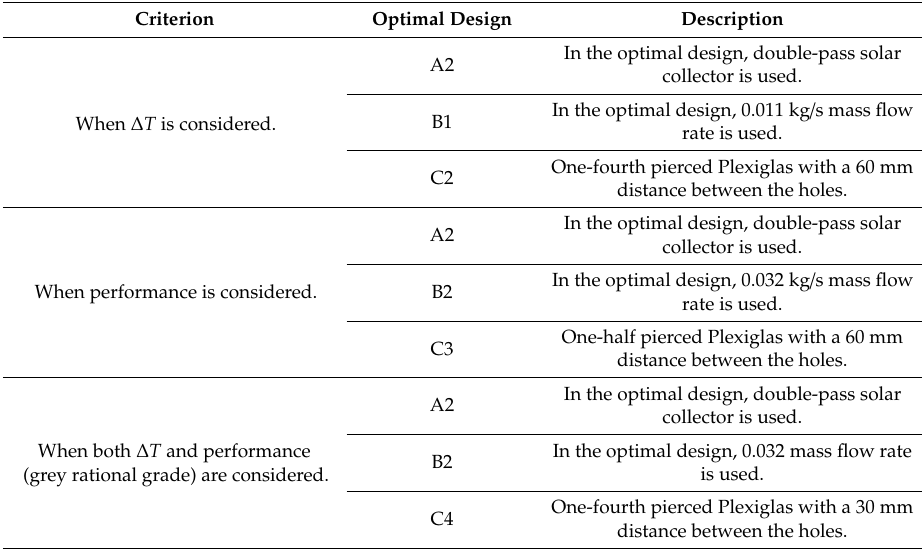
Table 8. Optimal design of the solar air heater considering di ff erent criteria.